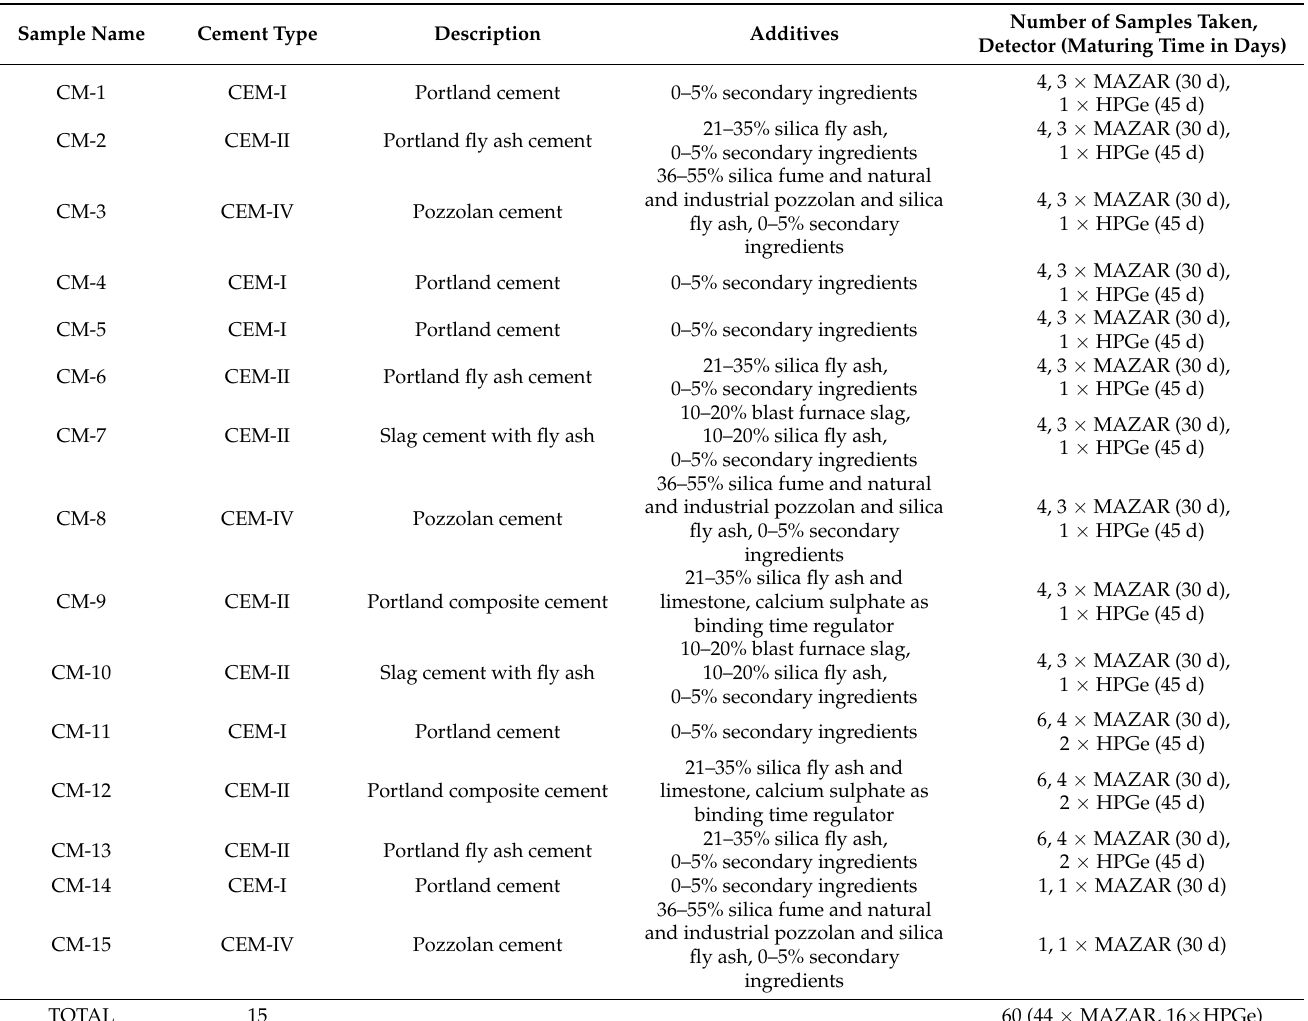
Table 1. Types of cement commercially available on the Polish market with description and additives shown. The last column presents the number of samples, the aging time and the type of detector that collected the gamma spectra during the